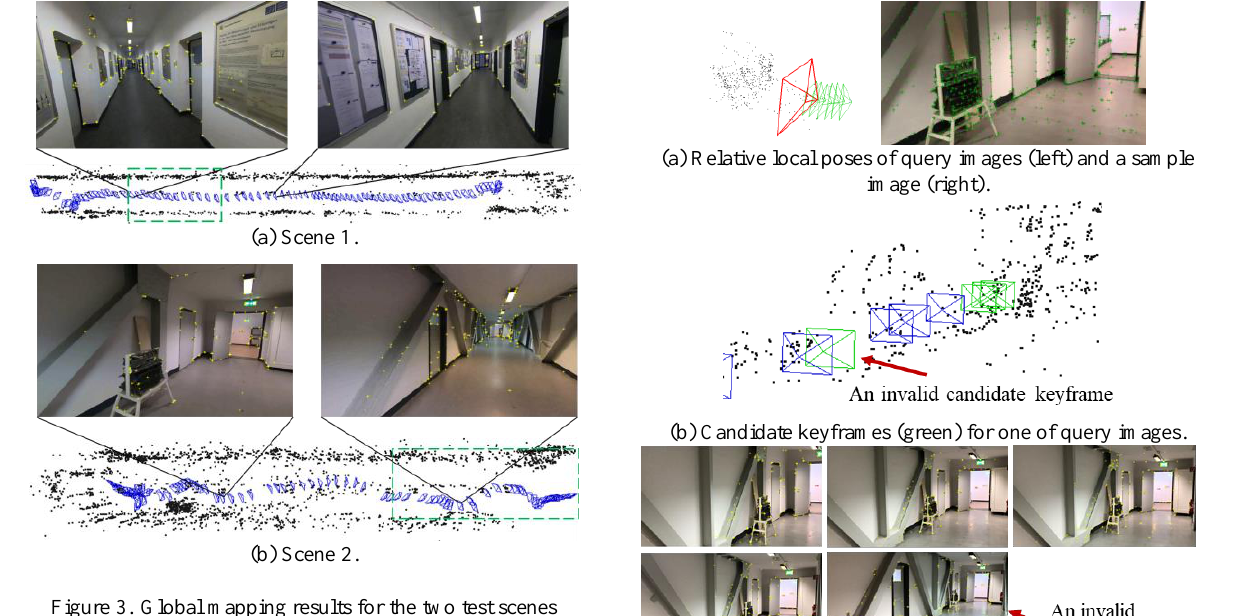
Figure 3. Global mapping results for the two test scenes (bottom) with sample images from the sequences (top).